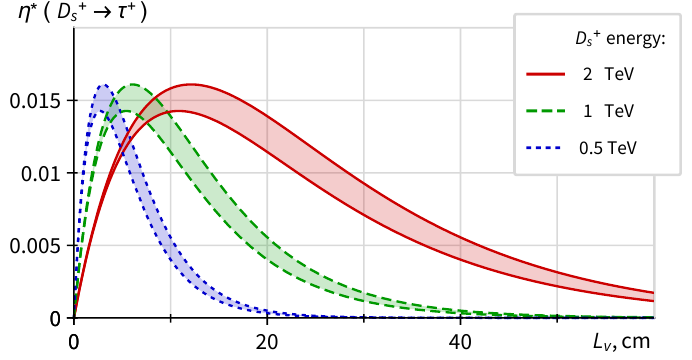
(cid:28) + conversion e(cid:14)ciency as a function of the (cid:13)ight length. Figure 11 . D + s ! lepton. The upper and lower edges correspond to upper and lower limits of the (cid:28) energy given in eq.